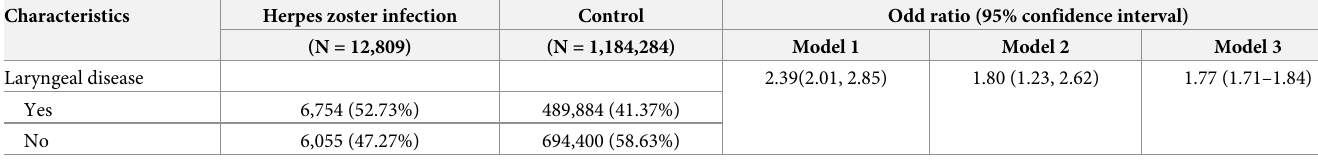
Table 2. Crude and adjusted odd ratios (95% confidence interval) of laryngeal disease for herpes zoster infection. Characteristics